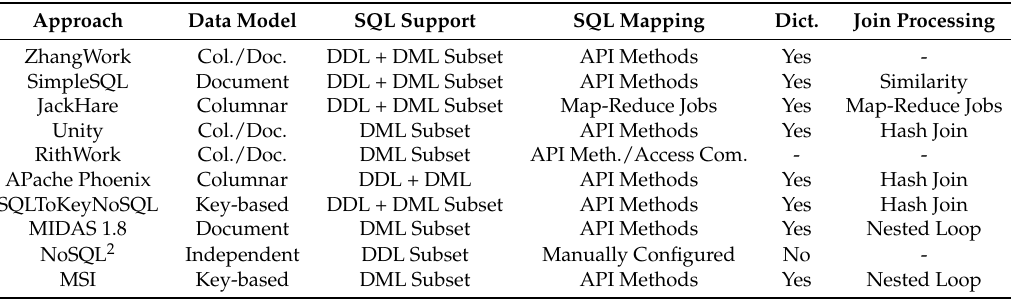
Table 1. Comparison of layer